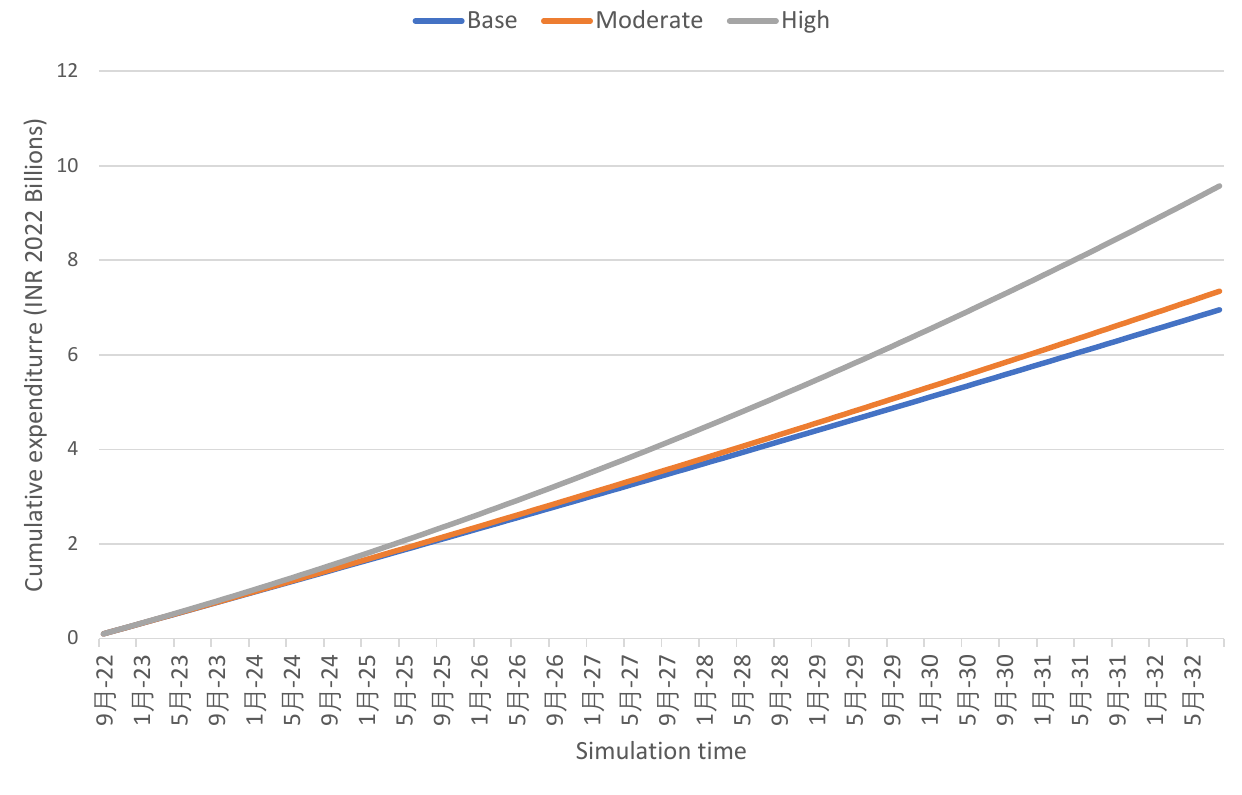
Figure 6. Sensitivity of the model to changes in fuel tariffs.